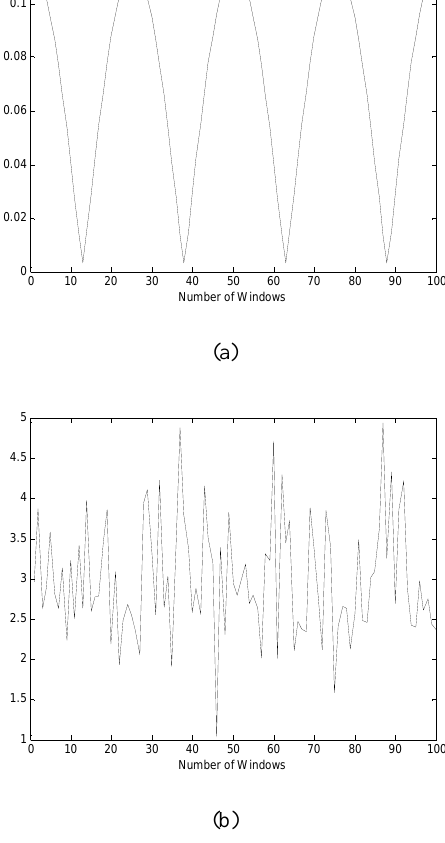
Fig. 8. Anomaly detection results of detectors. (a) anomaly detection results of detectors before censoring, (b) anomaly detection results of detectors after